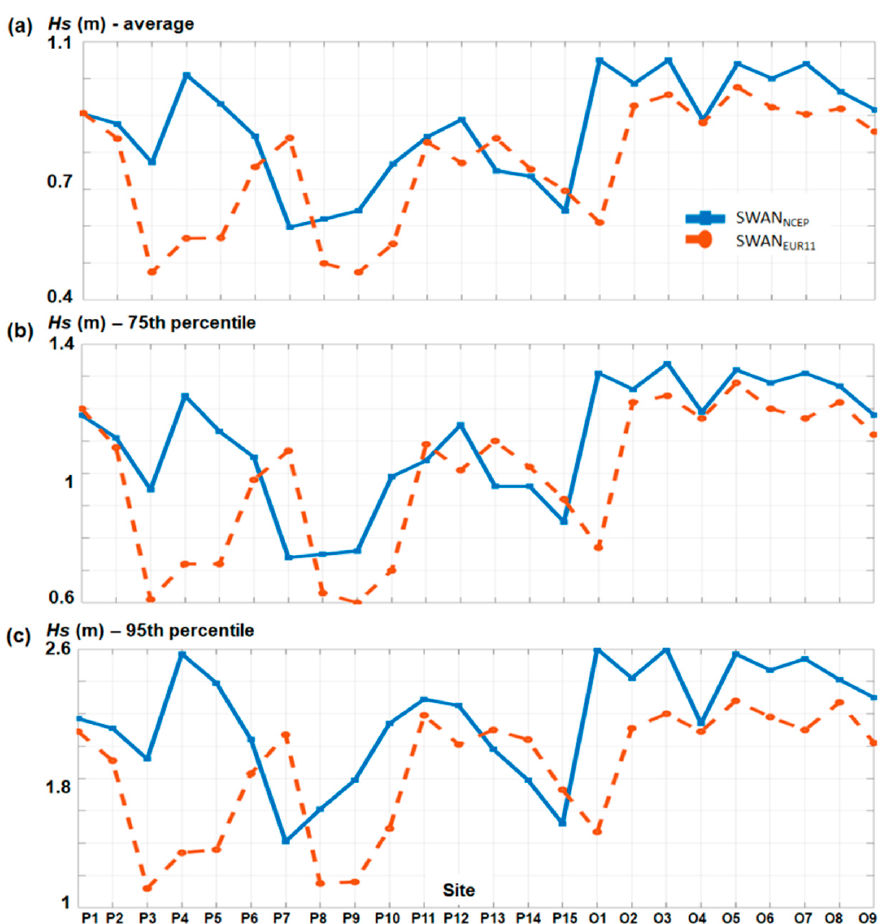
Figure 12. Assessment of the average Hs values in the sites considered, as provided by SWAN EUR11 and SWAN NCEP datasets for the time interval 1987–2009: ( a ) average values; ( b ) 75th percentile values; and, ( c ) 95th percentile values.